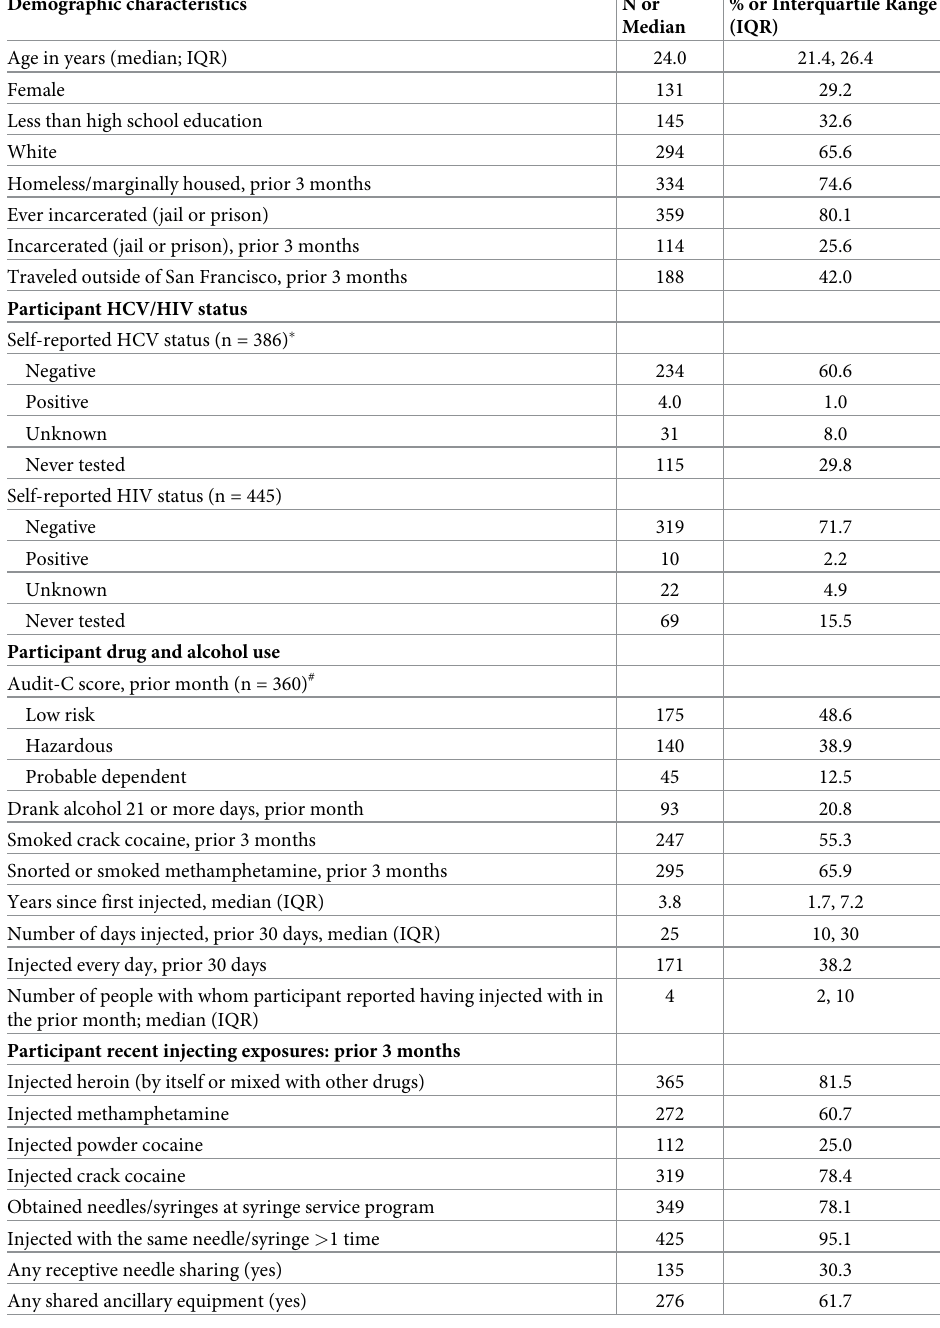
Table 1. Baseline demographic characteristics and recent injecting behaviors of hepatitis C virus (HCV) negative young injection drug users in San Francisco with � 1 injecting partner (N =